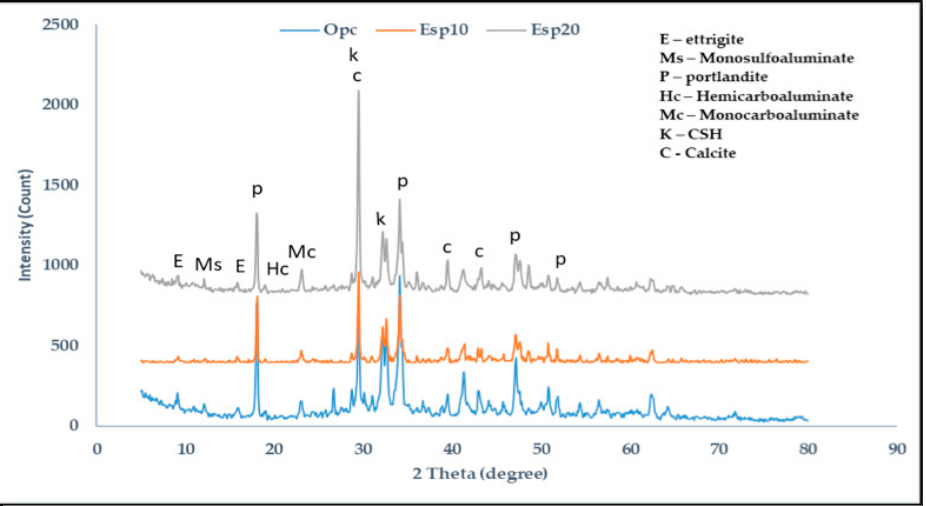
Figure 5. XRD analysis of 1-day cement paste.